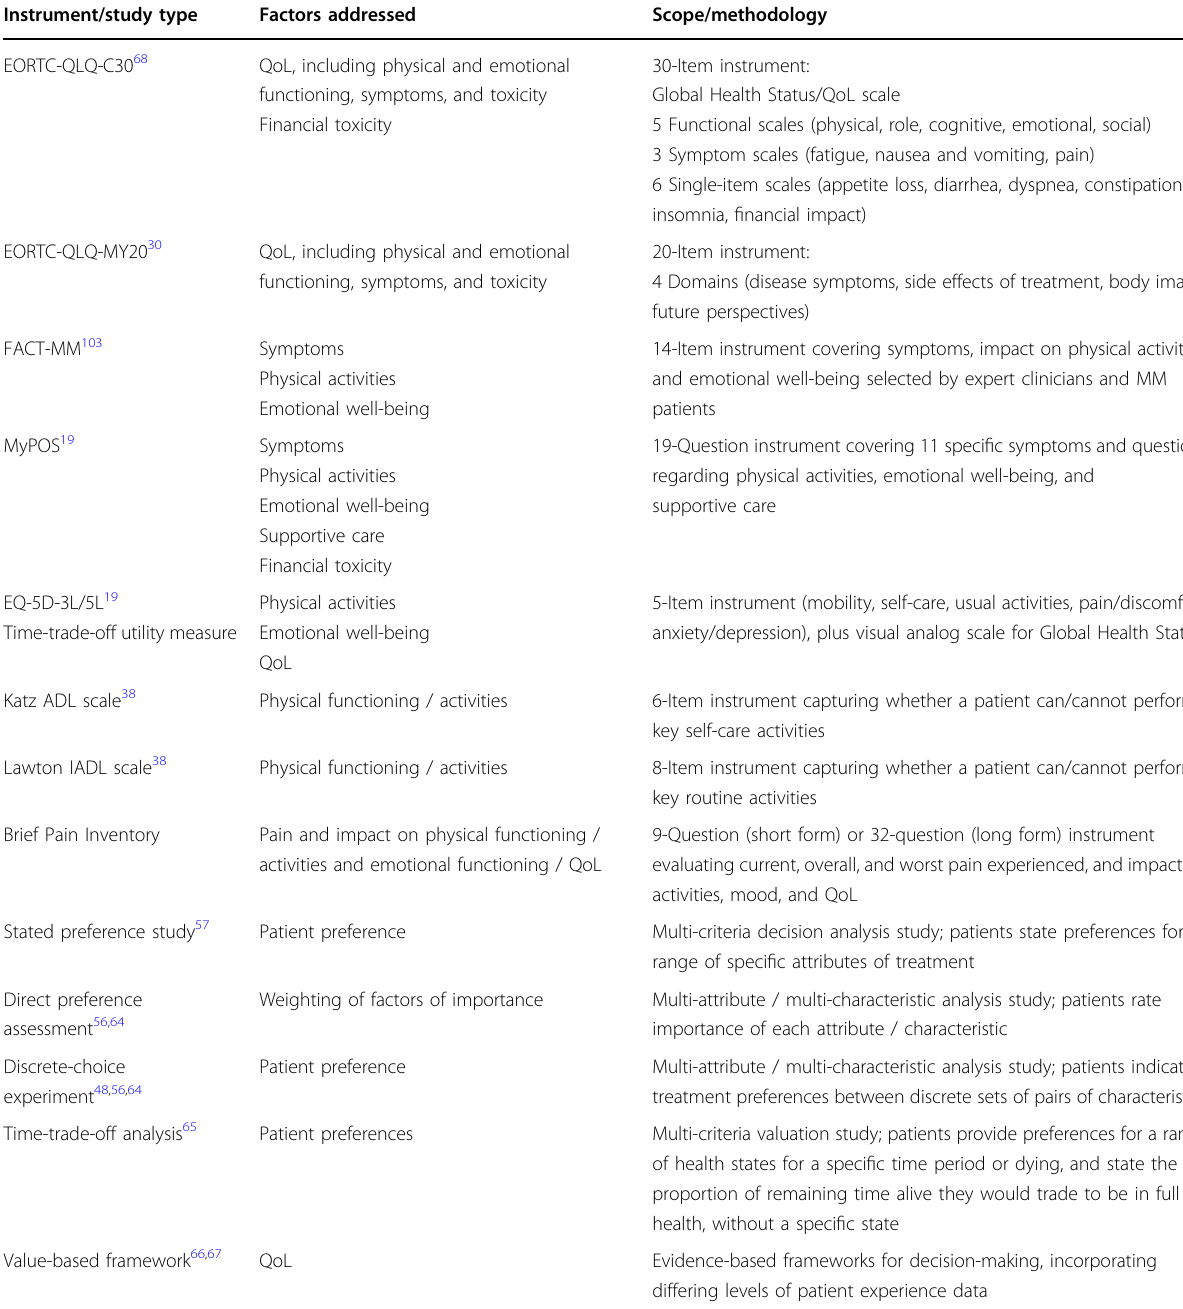
Table 2 Patient-reported outcome measures (PROMs), physician-completed instruments, and types of studies/patient- reported experience measures (PREMs) for capturing MM patients ’ treatment preferences and factors of importance to their treatment